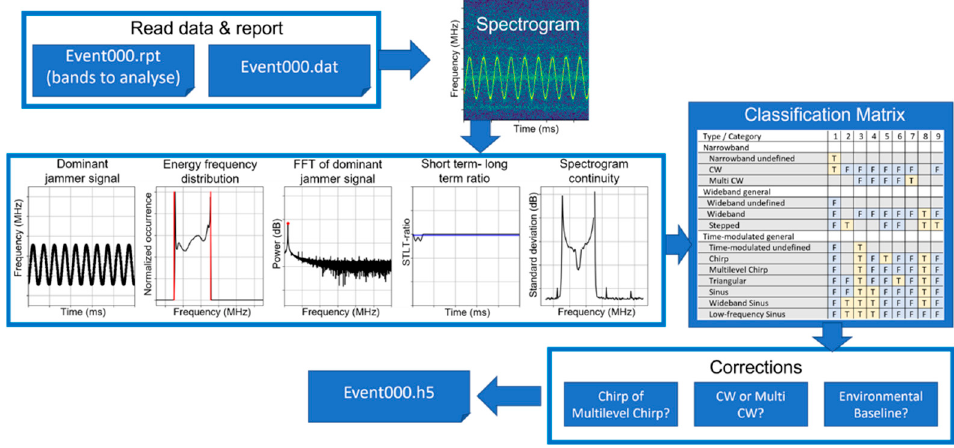
Figure 2. Automated RFI event characterization, classification and processing (adapted from [15]).